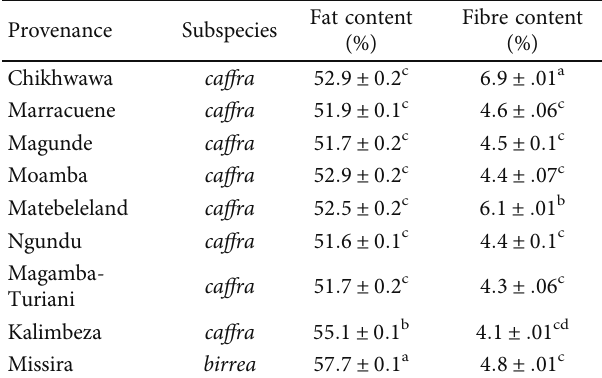
Table 4: Nutritional composition of S. birrea (subspecies ca ff ra and birrea ) seed kernel among nine